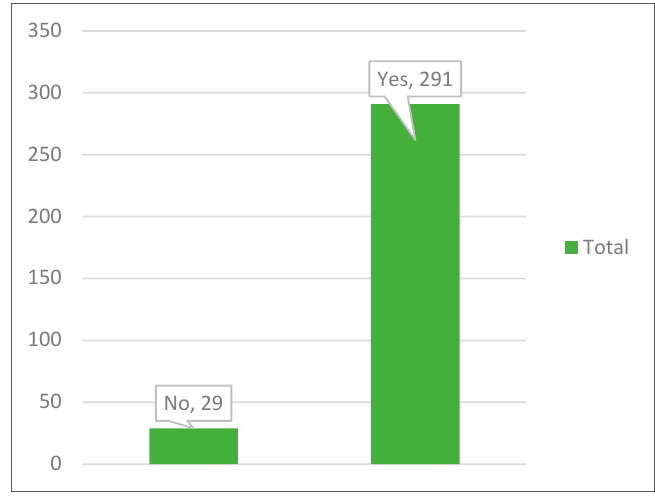
Figure 6. Students’ response to the impact of digital learning.